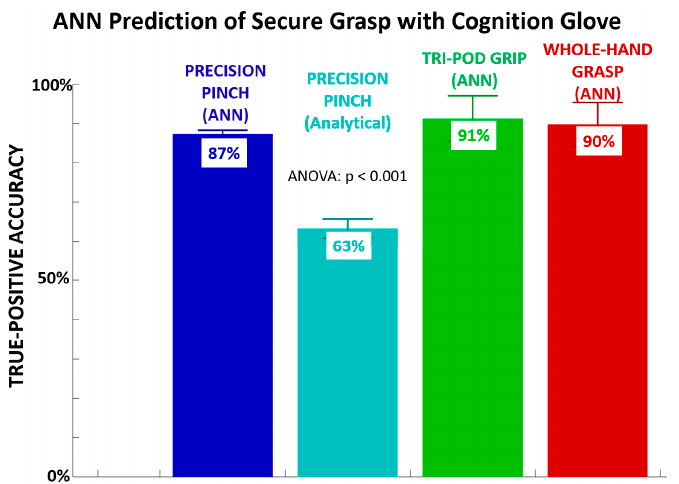
Table 2. Mean value comparisons for prediction (true-positive rate, %) of secure grasp.